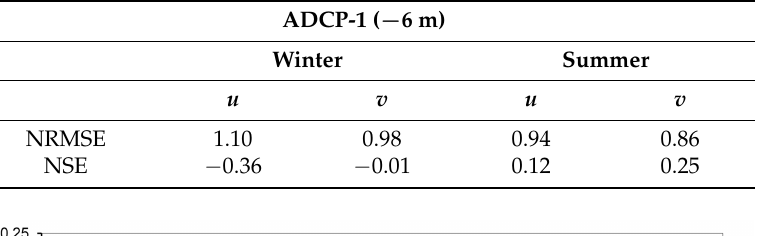
Table 4. Normalized root-mean-square error (NRMSE) and Nash-Sutcliffe efficiency index of the measured and modelled velocity values.